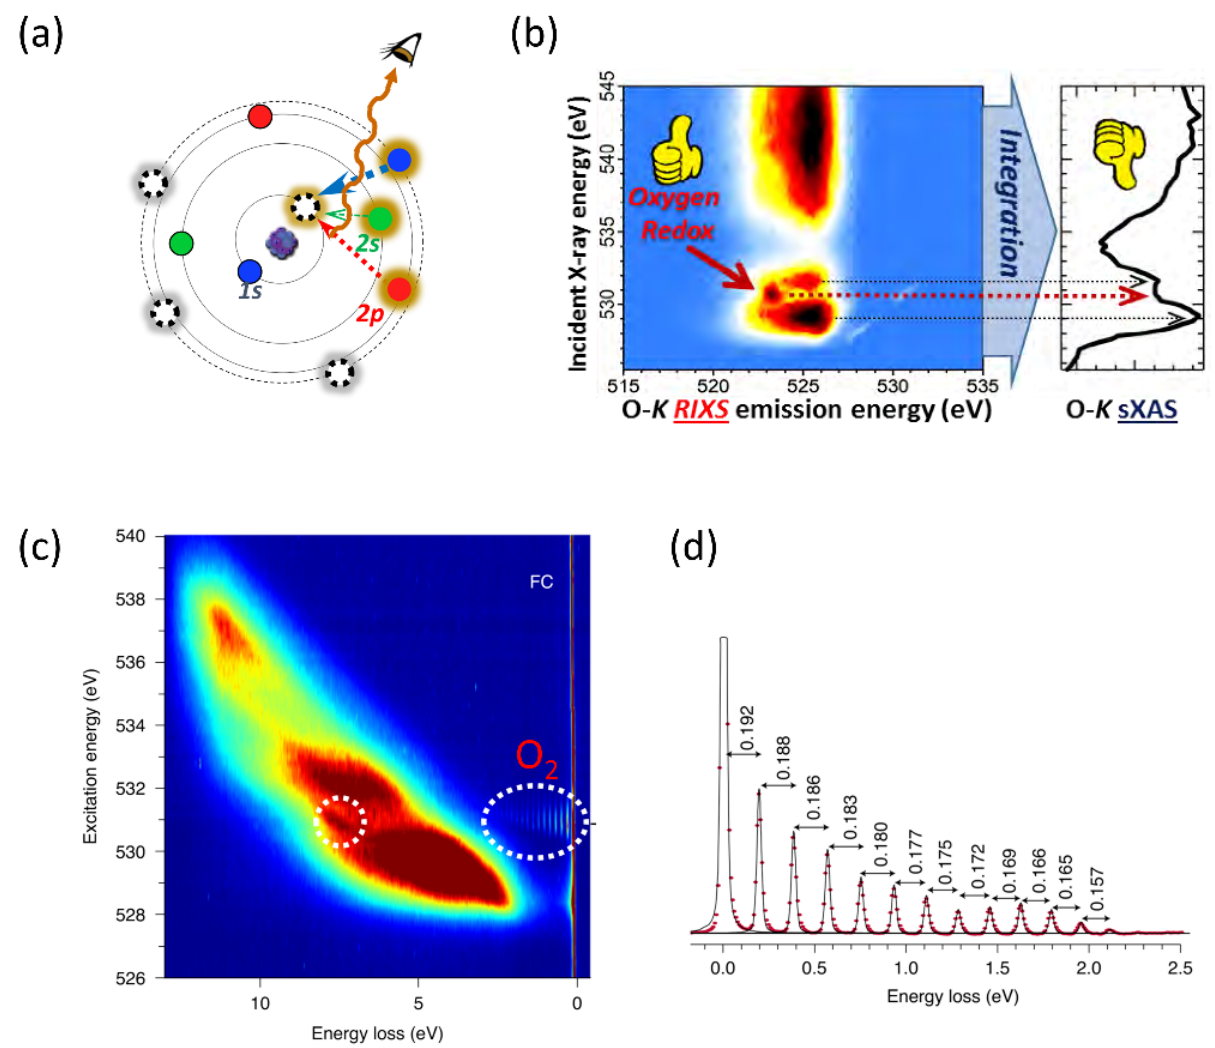
Figure 5. ( a ) Schematic of RIXS; ( b ) mRIXS map of O K-edge compared with corresponding XAS spectrum of Li 1.2 Ni 0.2 Mn 0.6 O 2 . ( c ) HR-RIXS map of O K-edge and ( d ) the low-energy loss feature of Li 1.2 Ni 0.13 Co 0.13 Mn 0.54 O 2 . Reproduced with permission from Refs. [24,29] Copyright 2018,